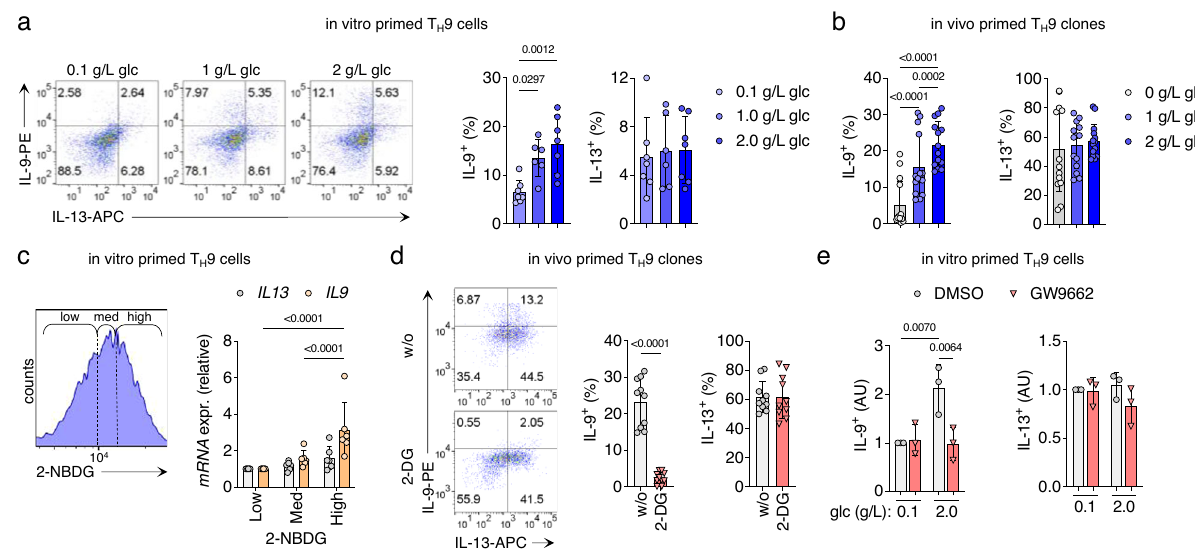
Fig.3|HighglycolyticactivityofT H 9cellsregulatesspeci fi ceffectorfunctions. a Cytokine expression measured by fl ow cytometry of T H 9 cells primed in vitro in media containing glucose of different levels for 7 days. b Cytokine expression of invivoprimedT H 9clonesculturedfor72hinmediacontainingglucoseofdifferent levels, measured as in a . c In vitro primed T H 9 cells were activated for 4h with α CD3/CD2/CD28, then sorted by fl ow cytometry based on their glucose uptake measured by 2-NBDG uptake (left). Cytokine expression in the sorted T H cell populations was measured by RT-qPCR (right). d Cytokine expression of in vivo primed T H 9 cells cultured for 7 days in the presence of 2-DG, measured as in a